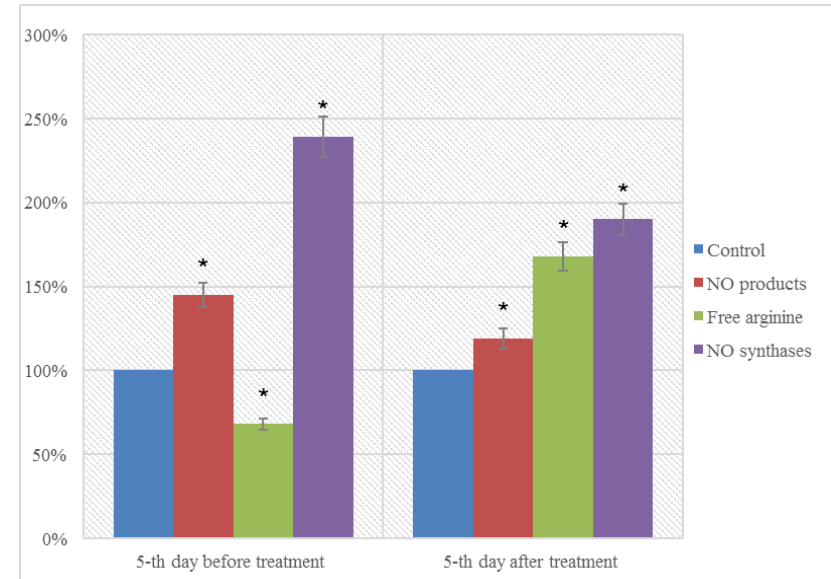
Fig. 4. The effect of the drug L-arginine on the activity of the NO system in the blood in adrenaline-induced myocardial injury under immobilization stress (in % comparison for 5 days before and after treatment): * – p<0.05 compared to the indicator in the control